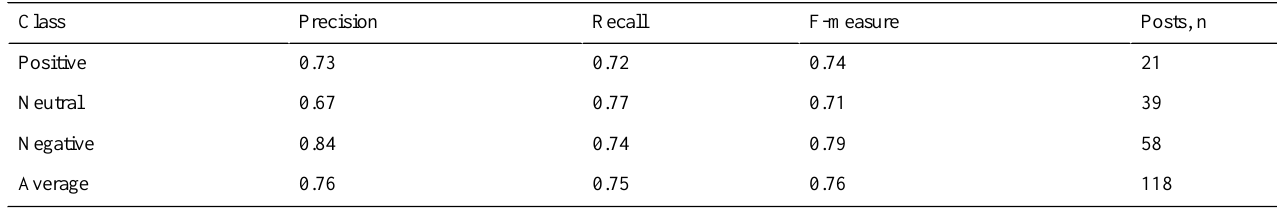
Table 3. Test data classification accuracy (N=118).